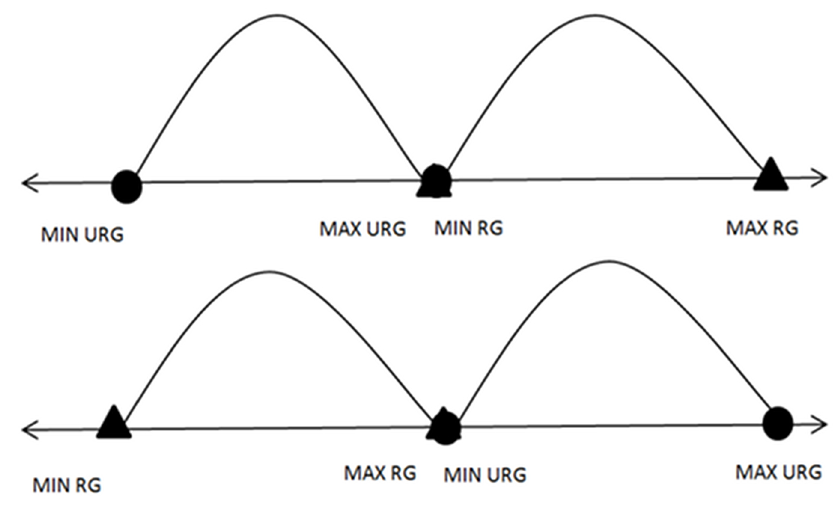
Figure 4. Generating meaningful virtual samples based on a Gaussian distribution.